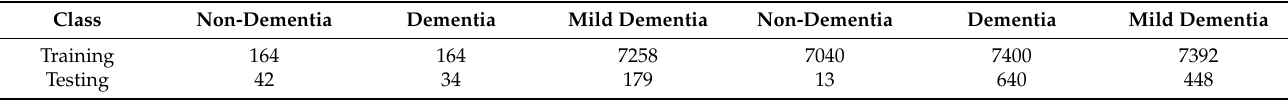
Table 7. Splitting the two data